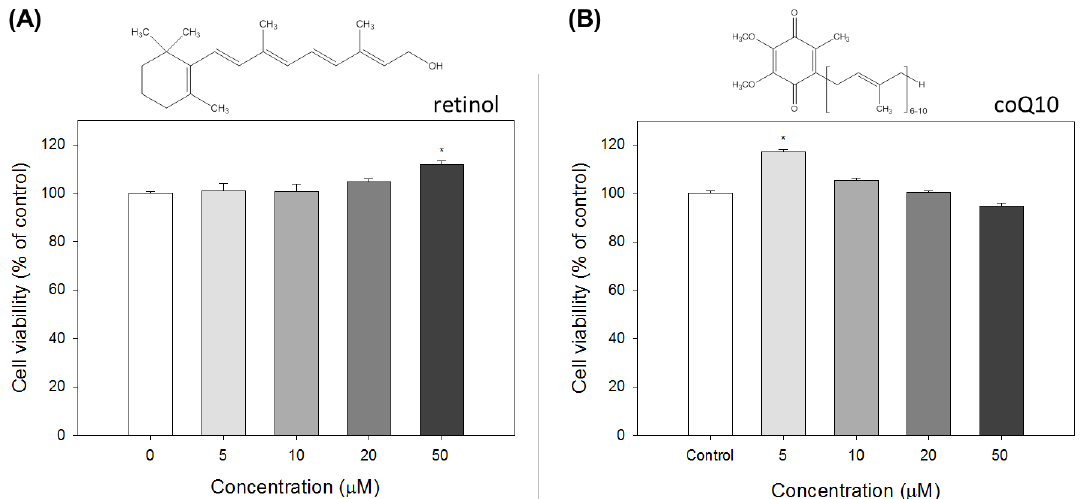
Figure 6. Cytotoxicity of ( A ) retinol and ( B ) coenzyme Q10 (coQ10) in human fibroblast Detroit 551 cells. Data are presented as means ± SE; * indicates a p value of less than 0.05 when compared with the control.